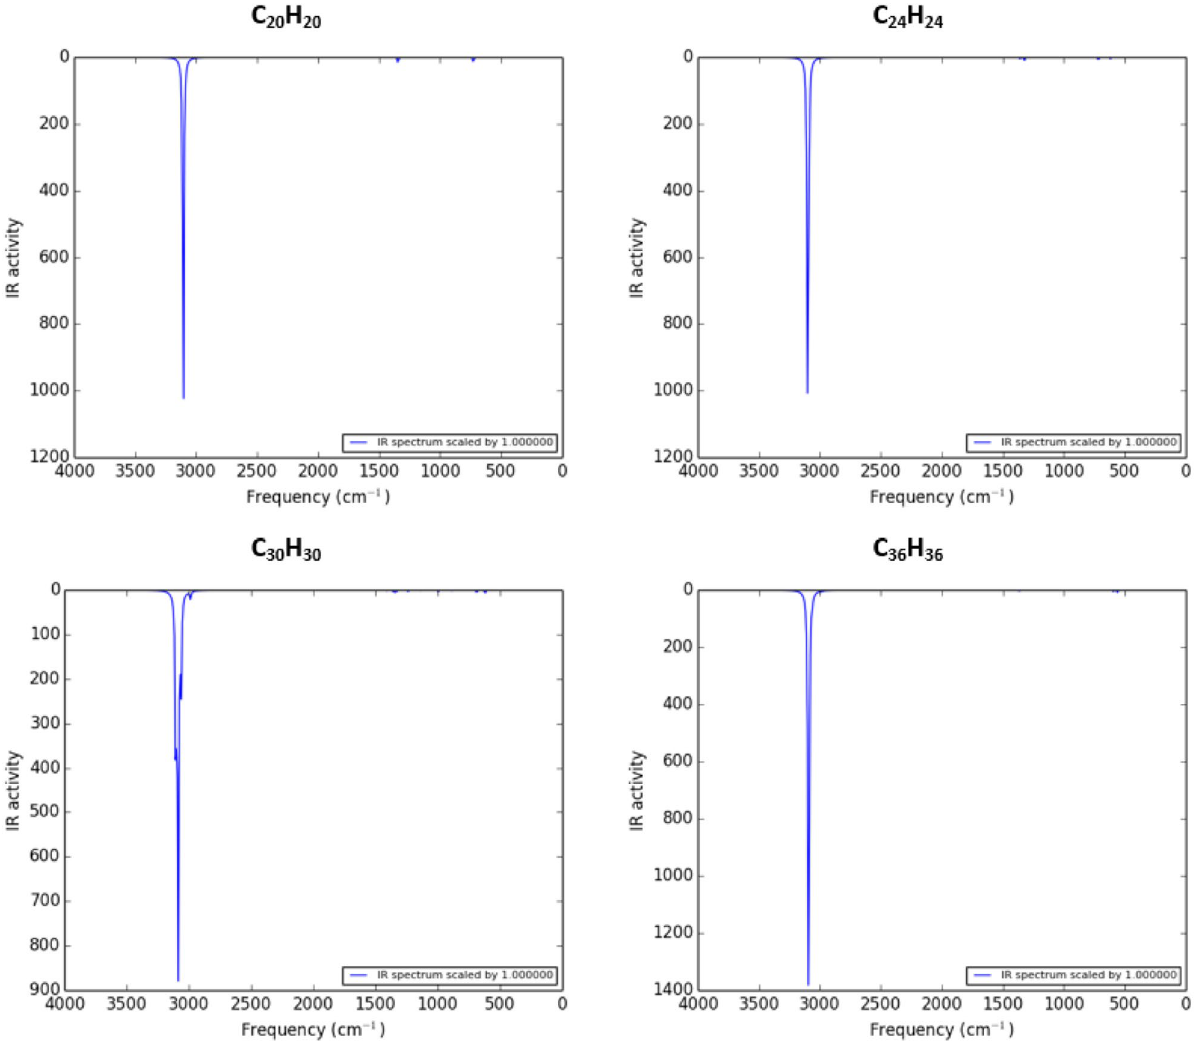
Figure 4. The infrared spectrum of fulleranes, foundations for introducing new structures.